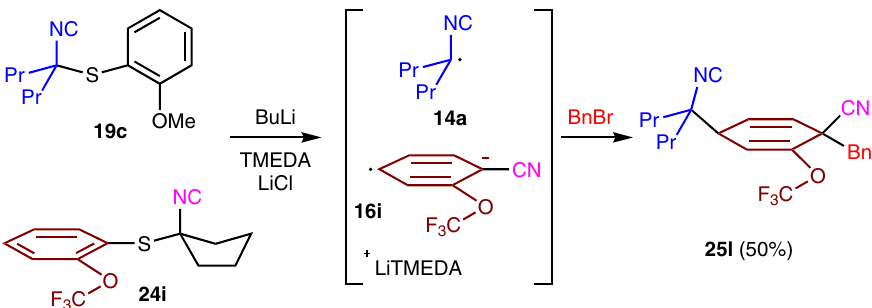
Fig. 8 | Crossed dearomatization with a matched isocyanide pair. Electron-rich 19c serves as the isocyanide donor and the electron-de fi cient 24i as the aromatic acceptor in forming cyclohexadiene 25l